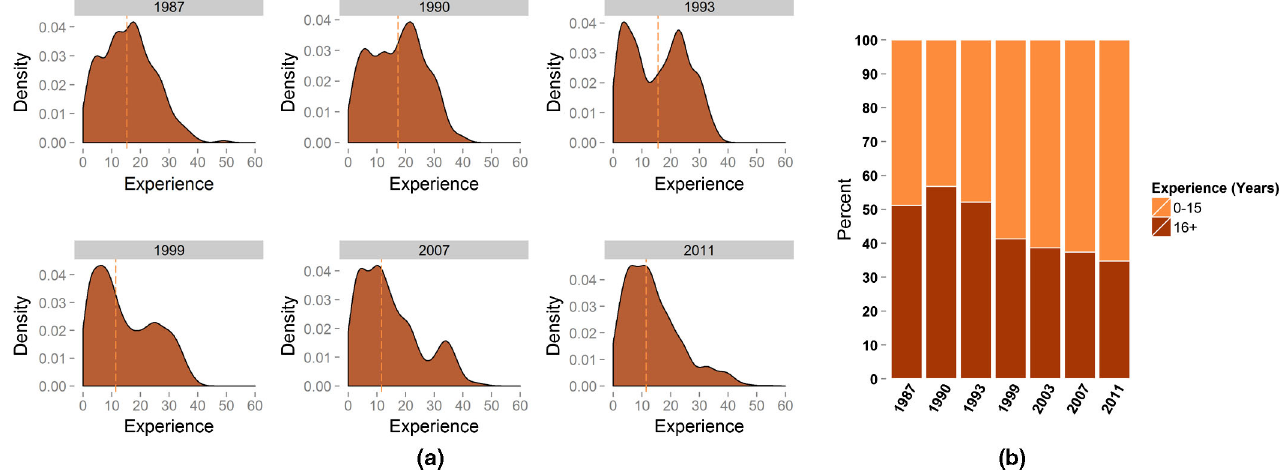
FIG. 5. (a) Kernel density plots for all physics teachers ’ experience between 1987 and 2011. The reference line in each panel represents the median for that survey year. (b) Percentages of all physics teachers with up to 15 years of teaching experience (orange) compared to those with more than 16 years over the time span studied (standard error ≤ 4 . 17 %).